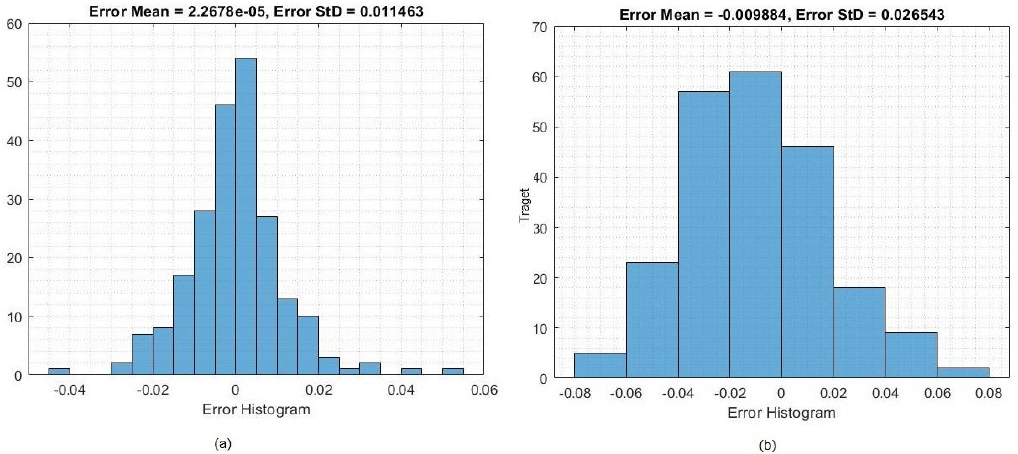
Figure 8. Rank correlation of deep learning models ( a ) CNN-LSTM and ( b ) LSTM for predicting the Tesla stock market closing price during the testing stage.